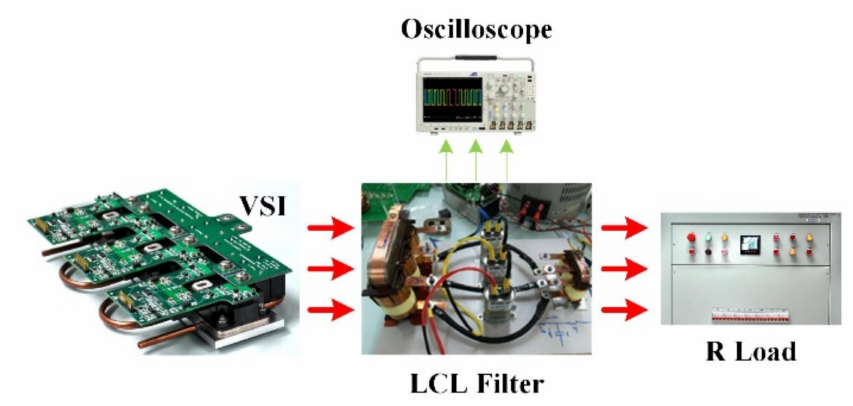
Figure 9. Experimental setup.